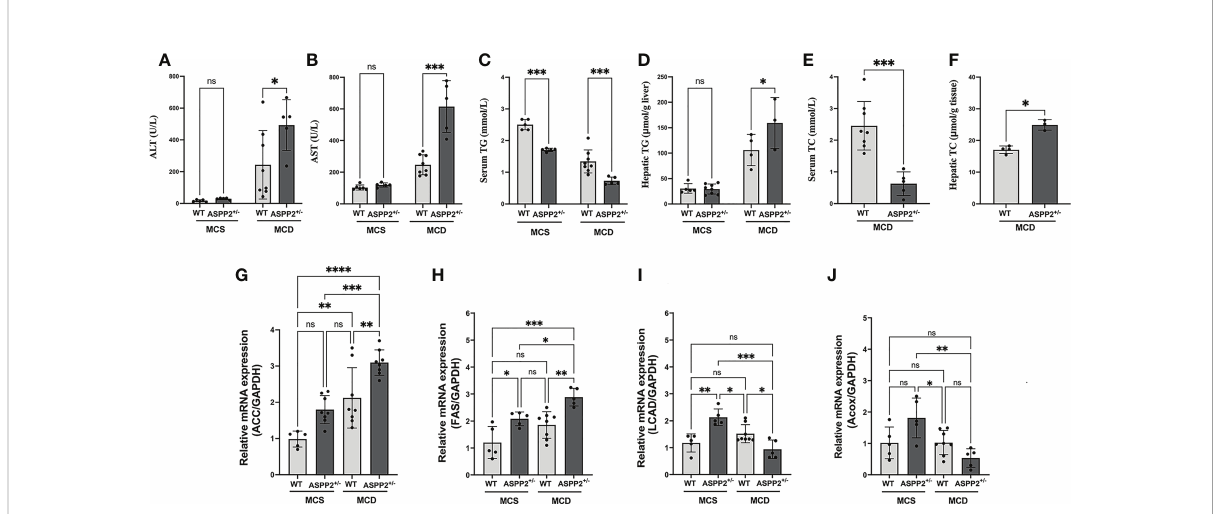
FIGURE 2 Blood chemistry analysis and expression of genes involving in lipid metabolism of ASPP2 knockout mice fed by MCS or MCD diet. (A) The serum ALT, (B) serum AST, (C) serum TG, (D) hepatic TG, (E) serum TC and (F) hepatic TG were measured using the ELISA kit; The mRNA expression levels of genes associated with fatty acid synthesis (G, H) and b -oxidation (I, J) . WT-MCS group, n = 5; ASPP2 +/ – MCS group, n = 4; WT-MCD group, n = 8; ASPP2 +/ – MCD group, n =5. *p < 0.05; **p<0.01; ***p<0.001; ****p < 0.0001. ns, no signi fi